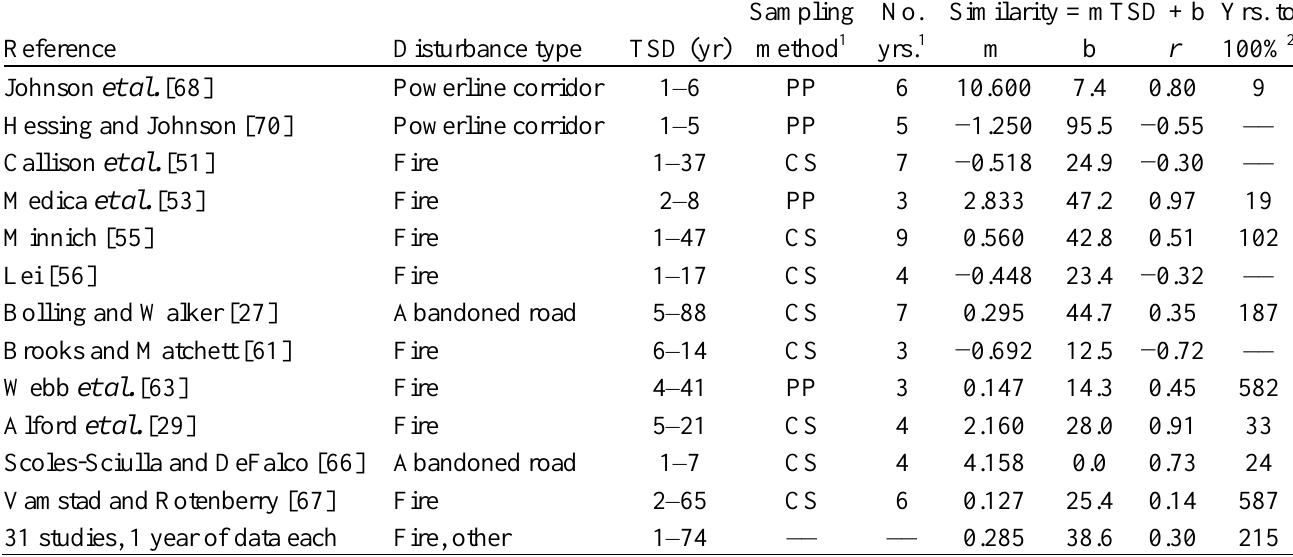
Table 3. Relationship of time since disturbance (TSD) and community percent similarity (Sørensen index) for perennial plants in the Mojave and Sonoran Deserts of the American